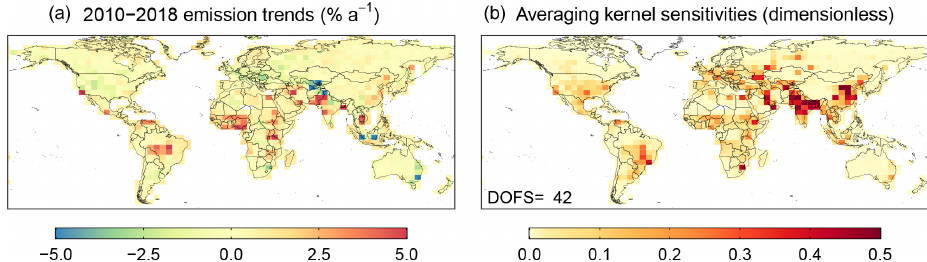
Figure 9. Anthropogenic methane emission trends for 2010–2018, as informed by GOSAT observations. (a) Relative emission trends on the 4 ◦ × 5 ◦ grid. Absolute emission trends are shown in Fig. S8. (b) Averaging kernel sensitivities that measure the ability of the observations to constrain the posterior solution (0: not at all, 1: fully). The degrees of freedom for signal (DOFS) are inset.